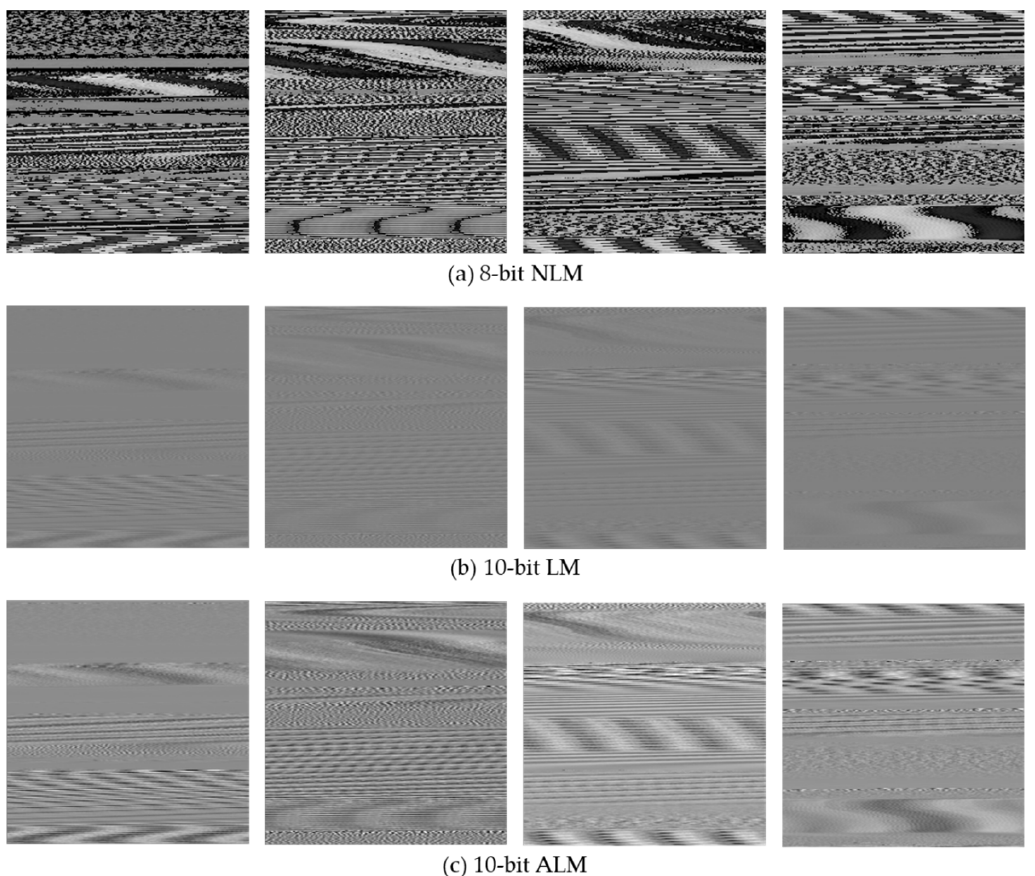
Figure 7. Visualization of consecutive 2D audio signals in the unit of frames (256 × 256 spatial resolution).